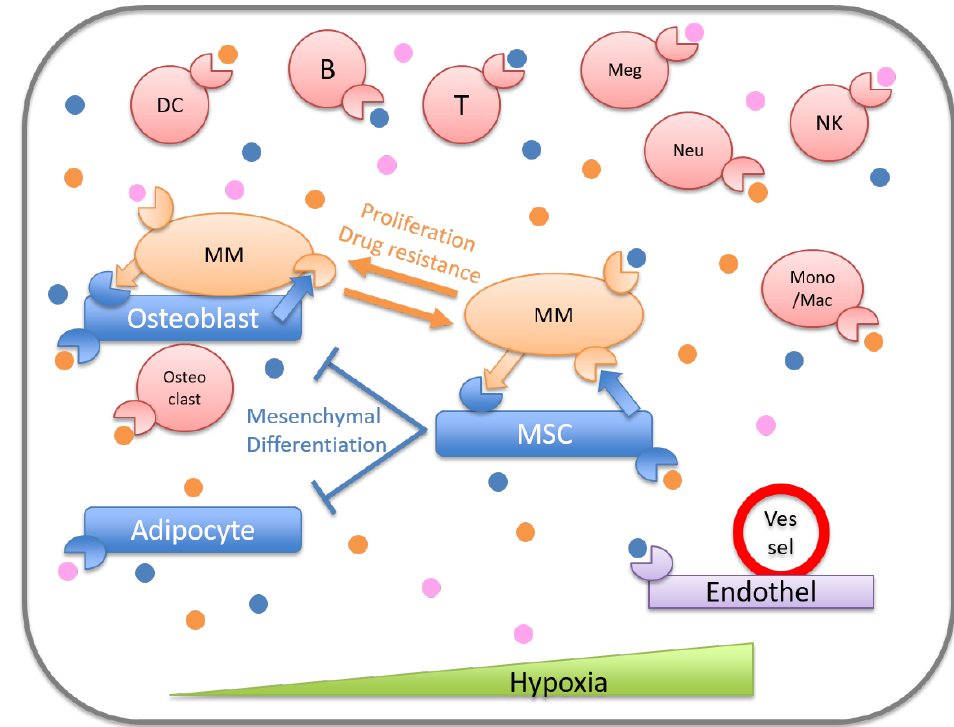
Figure 1. Bone marrow microenvironment of multiple myeloma. In bone marrow, myeloma cells and the surrounding cells interact with each other in direct or indirect ways, inducing a favorable environment for the survival of multiple myeloma. MM, multiple myeloma; MSC, mesenchymal stromal cell; Endothel, endothelial cell; Mono/Mac, monocyte or macrophage; NK, natural killer cell; Neu, neutrophil; Meg, Megakaryocyte; DC, dendritic cell; ●, soluble factors.